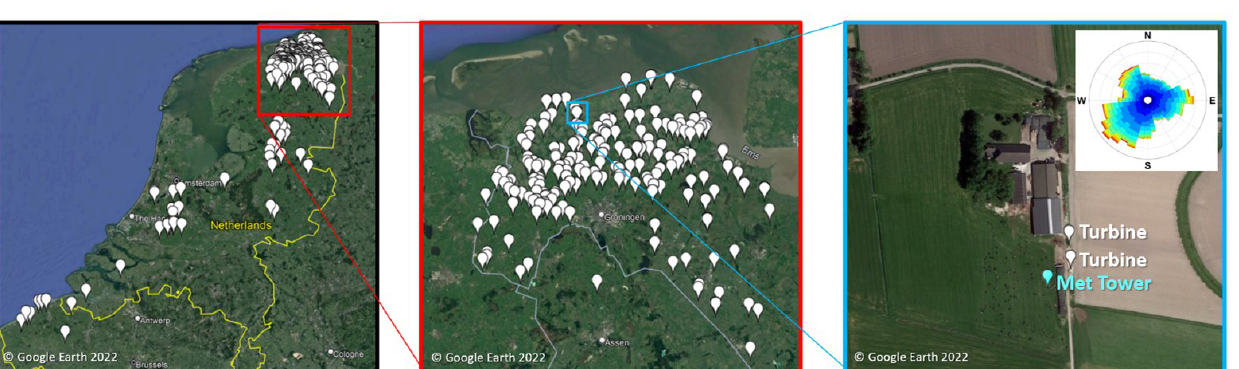
Figure 1. Production data were drawn from more than 300 turbines located in the northern Netherlands. Each turbine has a 15m hub height and provides power production data hourly. The area of detail includes the majority of turbines which are the focus of our obstacle modelling effort. An example site is given in the bottom right of the figure, showing the placement of two specific validation turbines, the IEC meteorological tower, and wind rose for this location. When the wind direction is north/northwest, these turbines are in the wakes of the buildings and trees on the site while other wind directions are largely free of